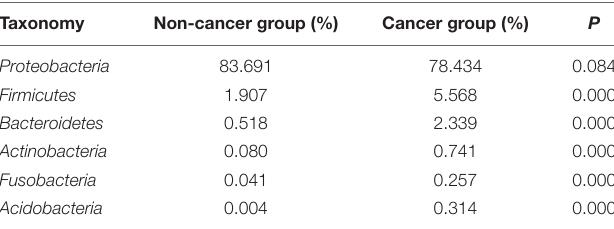
TABLE 1 | Baseline characteristics of the study subjects ( n = 62).